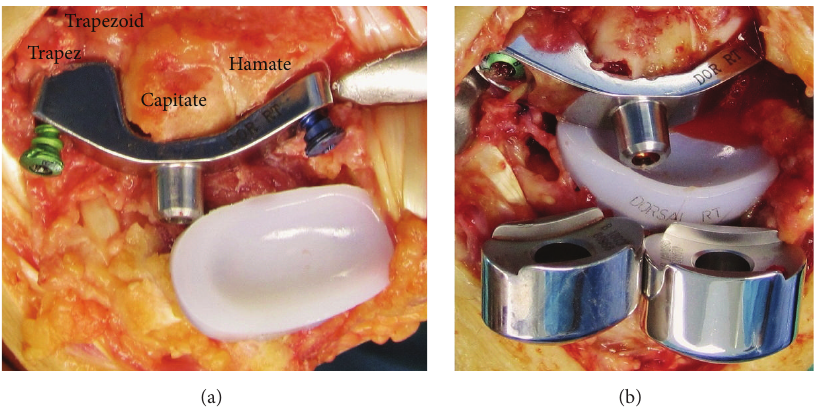
Figure 1: Technical note (Maestro WRS): (a) clinical photo demonstrating fixation of carpal component using a green-colored (mobile head) polyaxial and a blue-colored (rigid head) fixed locking screw; (b) clinical photo demonstrating placement of carpal heads onto the conus of previously inserted carpal